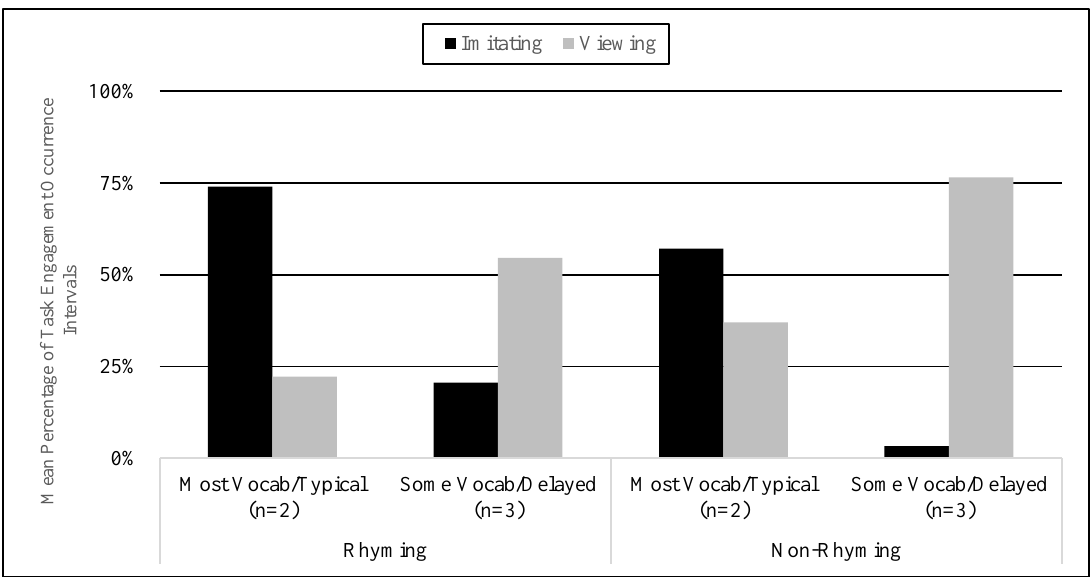
Figure 3. Mean Percentage of Task Engagement Occurrence Intervals in Viewing and Imitating Behaviors Across Phases in Some Vocabulary/Delayed and Most Vocabulary/Typical Groups.